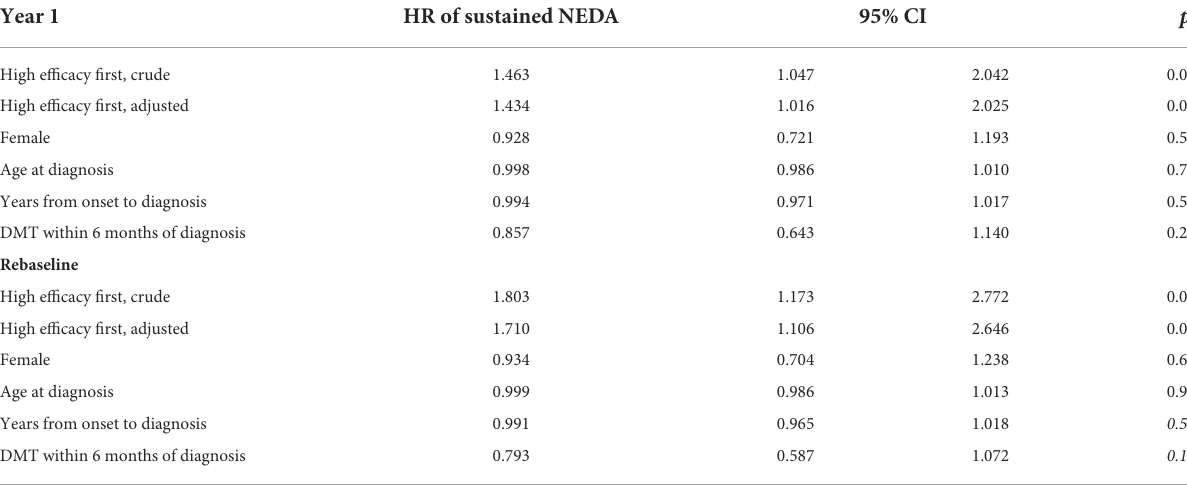
TABLE 3 Hazard ratio of sustained NEDA on high efficacy therapy compared to moderate efficacy therapy at year one and at rebaseline, before and after adjustment using cox regression